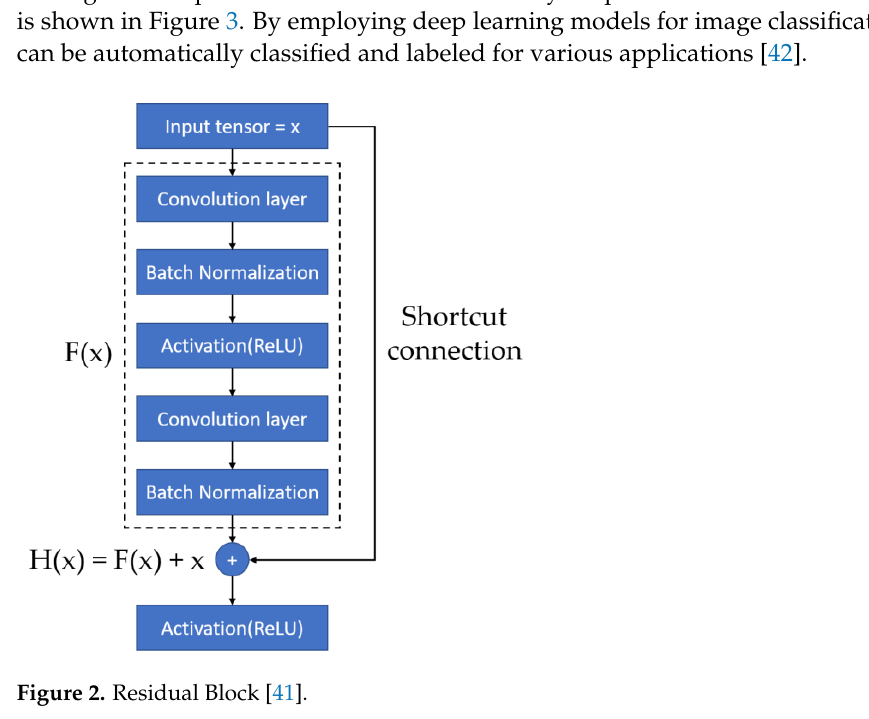
Figure 3. Residual Network Architecture [41]. 2.5. Technical Details and Evaluation Metrics The data were divided into training, validation, and testing sets. The validation set was taken from the training set at a 20:80 ratio. The testing set consisted of 24% of the total data and was used to evaluate the accuracy of the trained ResNet model. The inputs of the image classification model consisted of images with a size of 224 × 224 px, and the urinary tract stone images were diversified using data augmentation techniques (random rotation, horizontal/vertical translation, magnification/zooming out, and shear-mapping). The Keras API with the Tensorflow platform (version 2.9.1) was used to construct the Res- Net model. Ranger [43], which was created by combining RAdam [44] with LookAhead [45], was used as an optimizer. As with Adam, RAdam converges quickly and achieves a level of optimality similar to that of SGD. Furthermore, RAdam converges similarly with different learning rates, whereas Adam and SGD are much more sensitive to the learning rate and require optimization. Binary cross-entropy was used as a loss function. The